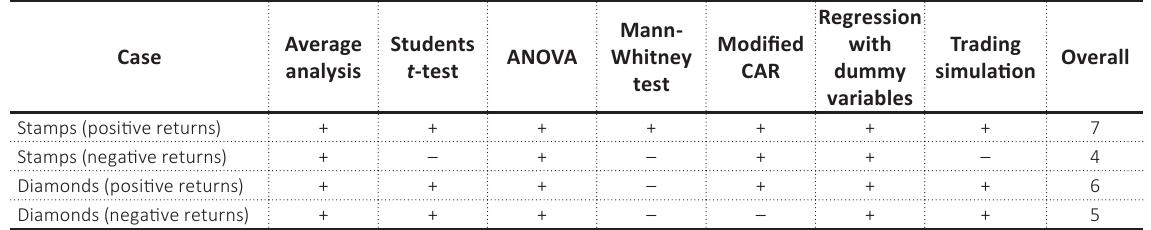
Table 2. Summary of results for the stamps and diamonds: The case of negative and positive